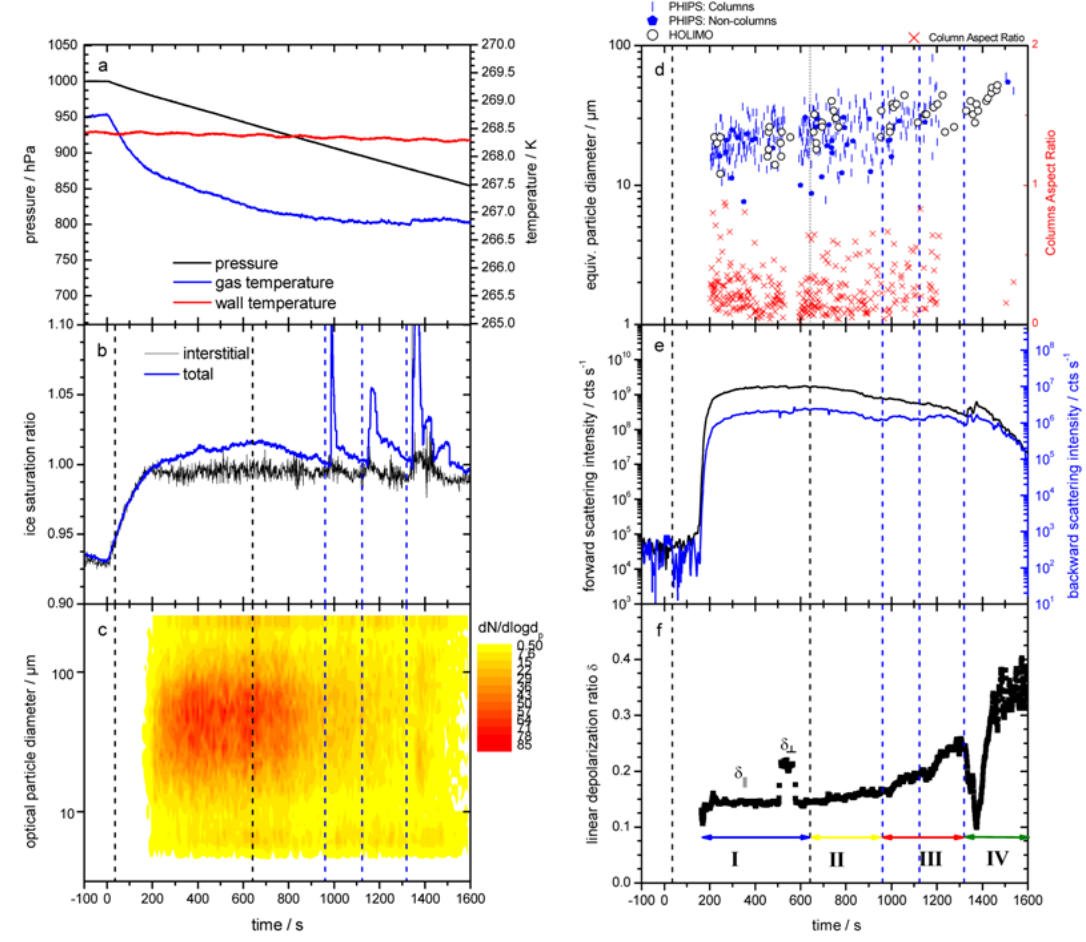
Fig. 9. Temporal evolution of the AIDA mixed phase cloud experiment HALO02 18. Panel (a) : wall and gas temperatures and pressure of the AIDA chamber. Panel (b) : ice saturation ratio of the total and interstitial water contents si in the AIDA volume. Panel (c) : optical particle diameter as measured by WELAS. Panel (d) : geometric particle diameters as measured by the HOLIMO and PHIPS imagers together with the aspect ratio solely deduced for the PHIPS detected columns. Panel (e) : near-forward (2 ◦ ) and near-backward (178 ◦ ) light scattering intensities measured by SIMONE. Panel (f) : backscattering linear depolarization ratio measured by SIMONE. See text for details.